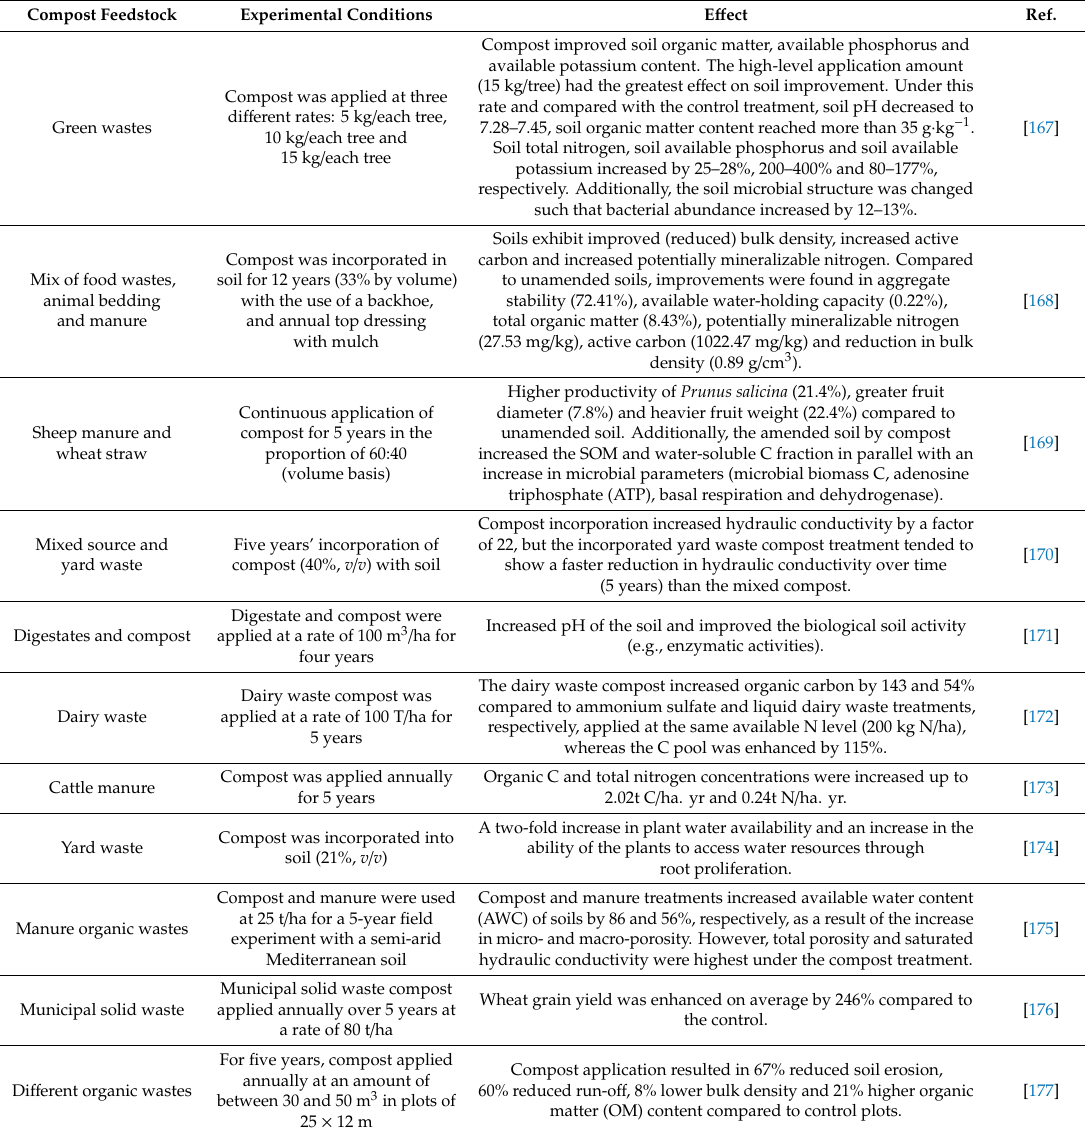
Table 1. E ff ects of compost application on di ff erent soil properties and crop